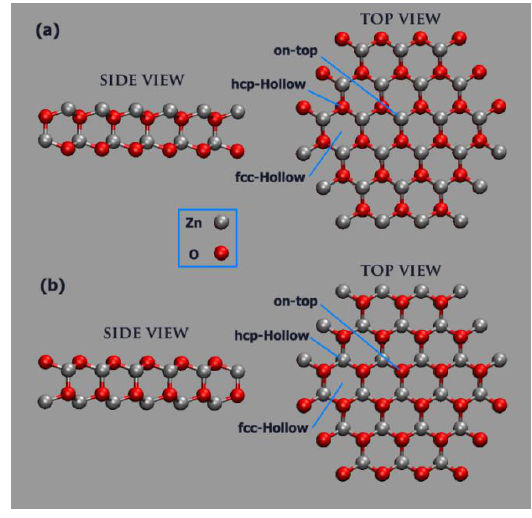
Figure 21. Schematic diagram of the high-symmetry adsorption sites on the two polar surfaces of ZnO, (a) for zinc surface termination top and side view, (b) for oxygen surface termination top and side